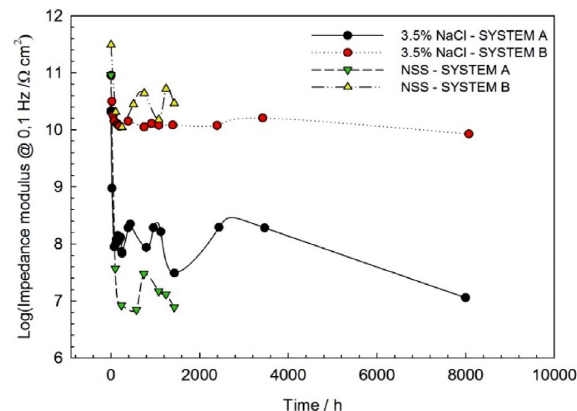
Figure 5. Photographs of specimens coating systems A and B before exposure, after exposure NSS and after exposure 3.5 wt% NaCl solu-